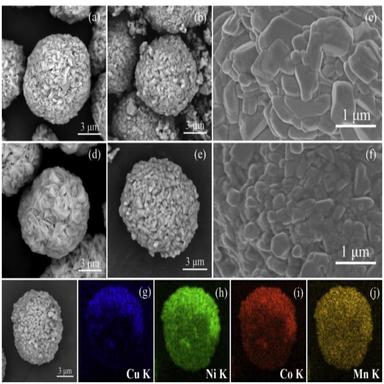
SEM images of Ni0.6Co0.2Mn0.2(OH)2 precursor (a), NCM622 sample (b, c), Ni0.6Co0.19Mn0.2Cu0.01(OH)2 precursor (d), and Cu-NCM sample (e, f). EDX element mappings of Cu-NCM particle (gej).